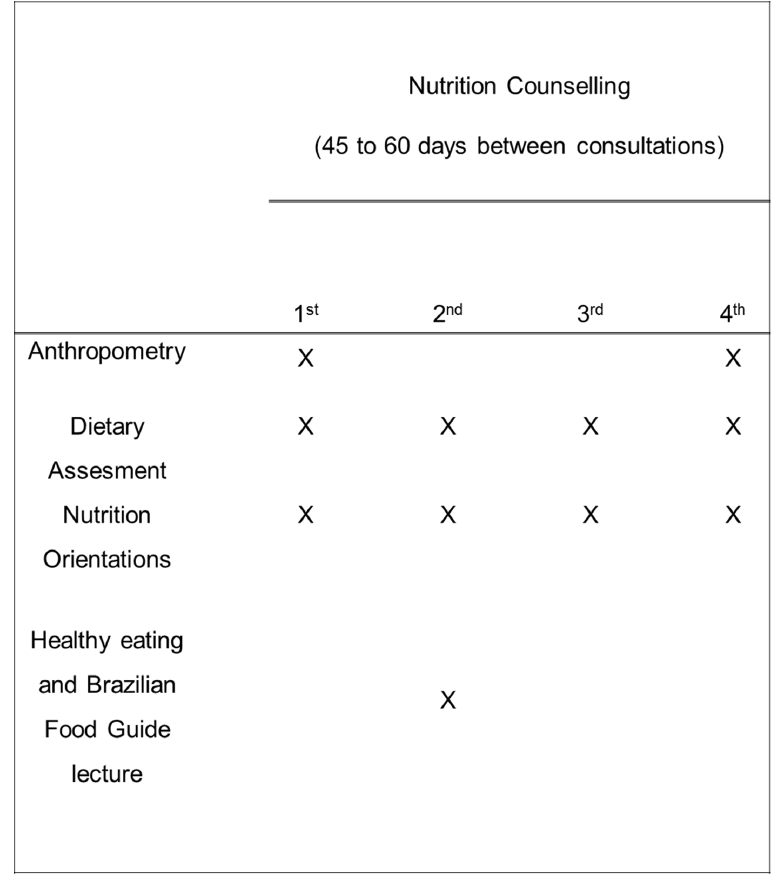
Figure 1. Experimental design of the study.